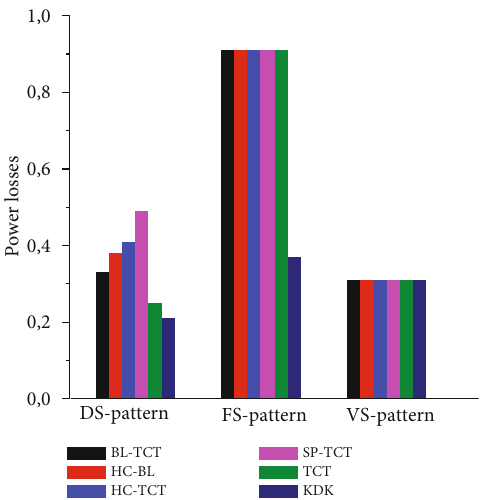
Figure 17: Power losses of the di ff erent topologies under scattered shading